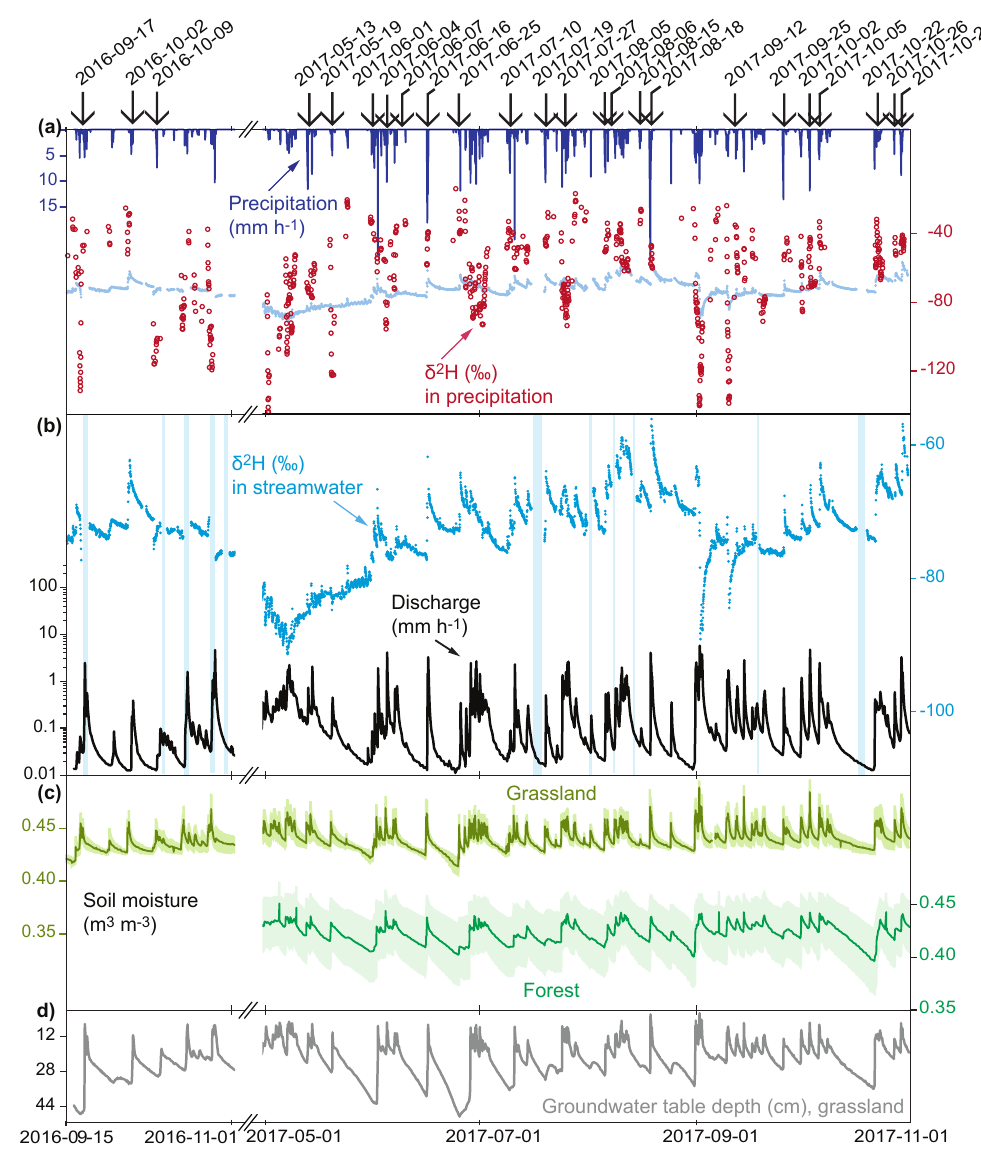
Figure 2. Time series of (a) precipitation and δ 2 H in precipitation ( δ 2 H in stream water is shown for comparison), (b) discharge (on log axis) and δ 2 H in stream water (vertical bars indicate gaps in the isotope data), (c) soil moisture measured at 50cm depth at the grassland and forest sites (Fig. 1a), with shaded areas showing the standard error from averaging the measurements from the four probes at each plot, and (d) groundwater levels at the grassland site. The winter period with snow cover (6 November 2016–7 May 2017) was not considered in this analysis, since the individual contributions of rainfall and snowmelt to river discharge could not be distinguished sufficiently. Vertical arrows indicate the events analysed in this